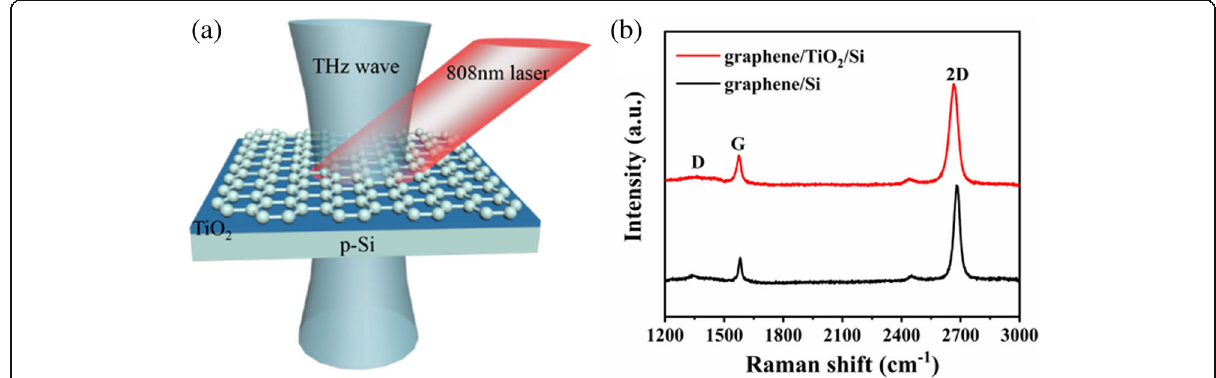
Fig. 1 Experimental design and Raman spectra of graphene. a Schematic of the all-optical THz modulator. The modulator is composed of a single-layer graphene on a p-Si substrate with TiO 2 film. b Raman spectra of the graphene on the Si and TiO 2 /p-Si substrates